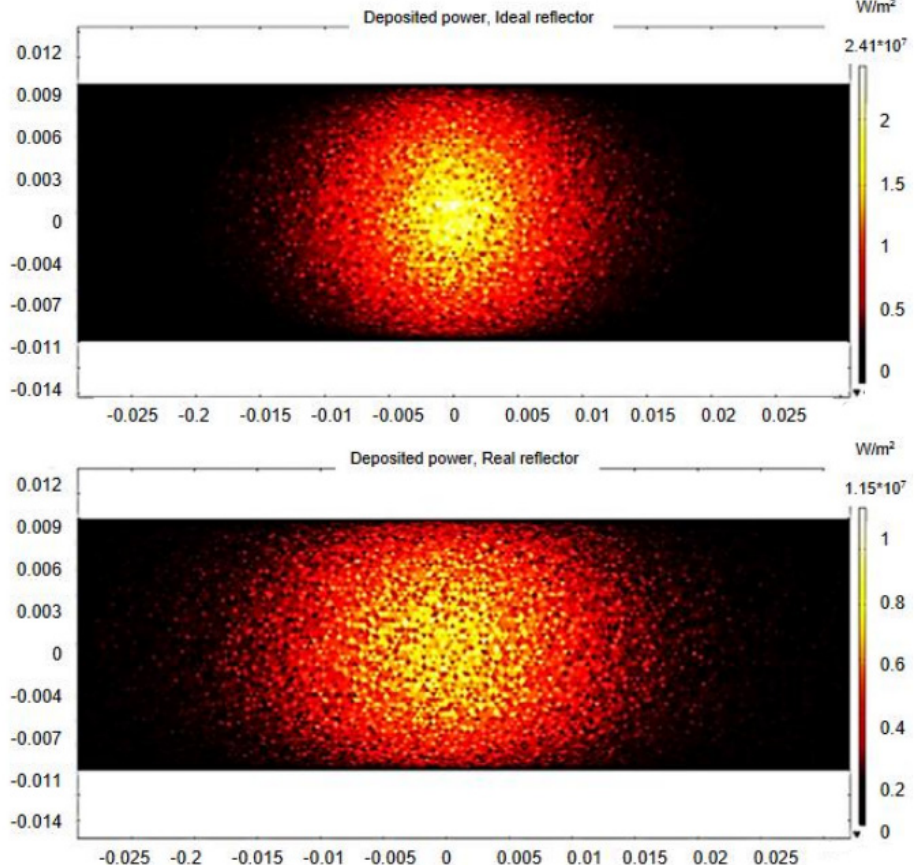
Figure 12. Distribution of thermal power deposited in the focal plane of receiver. Ideal case ( above ): perfectly smooth and reflective parabolic reflector; the phenomenon of solar limb darkening was neglected. Real case ( below ): parabolic reflector in which factors such as surface roughness, absorption and solar limb darkening were included.